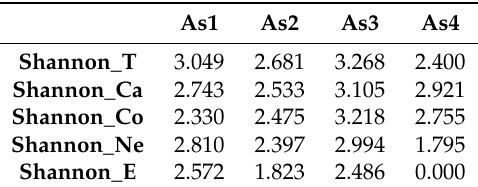
Table 5. Diversity analysis of each of the four plant